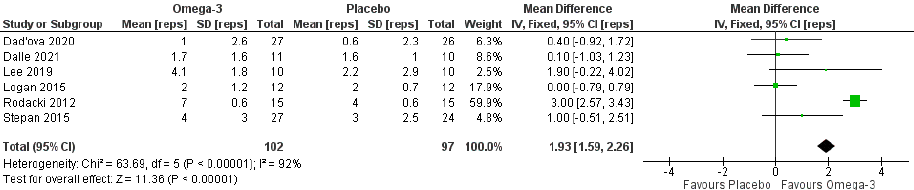
Figure 5. Pooled analysis of the impact of omega-3 supplementation on timed-up-and-go test. Note